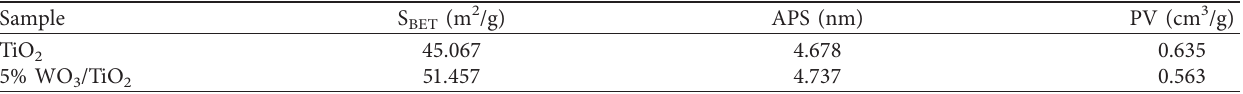
2 and 5% WO 3 /TiO 2 nanofibers.